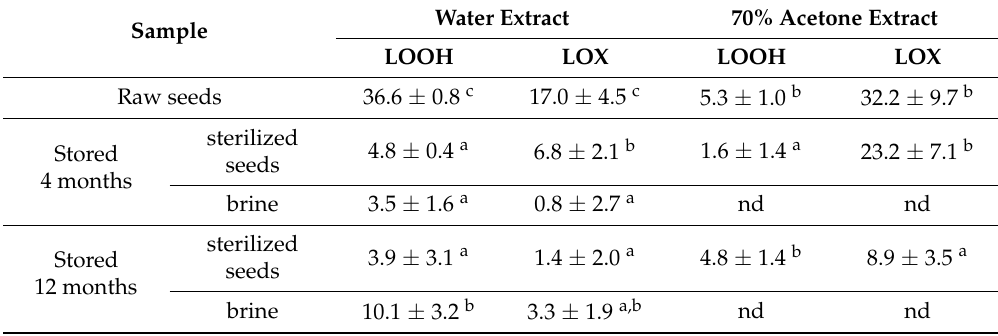
Table 6. Antioxidant activities (%) of the extracts investigated against linoleic acid autoxidation (LOOH) and lipoxygenase-catalyzed oxidation (LOX); (nd—not determined). Water Extract 70% Acetone Sample